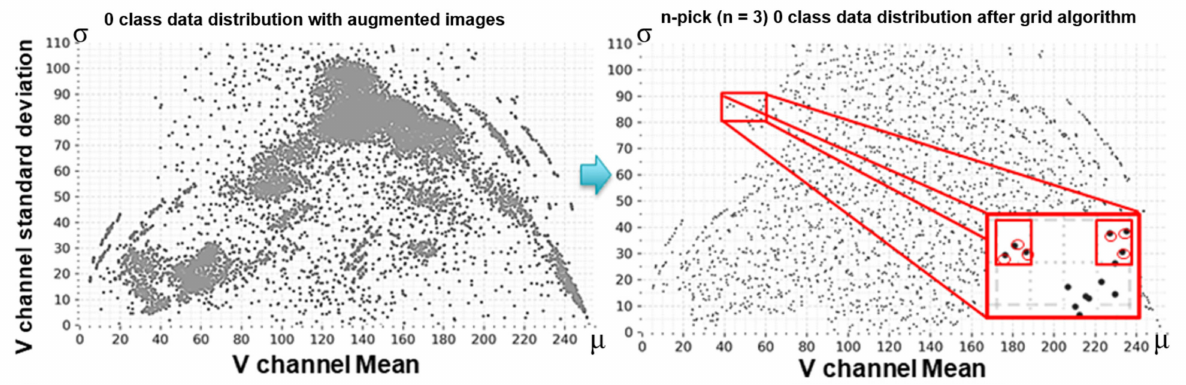
Figure 12. Data reduction using the grid algorithm. The left part of the figure is a mixture of both original data 1, 2, and augmented data in class 0. The right part of the figure shows the result after applying the n-pick sampling